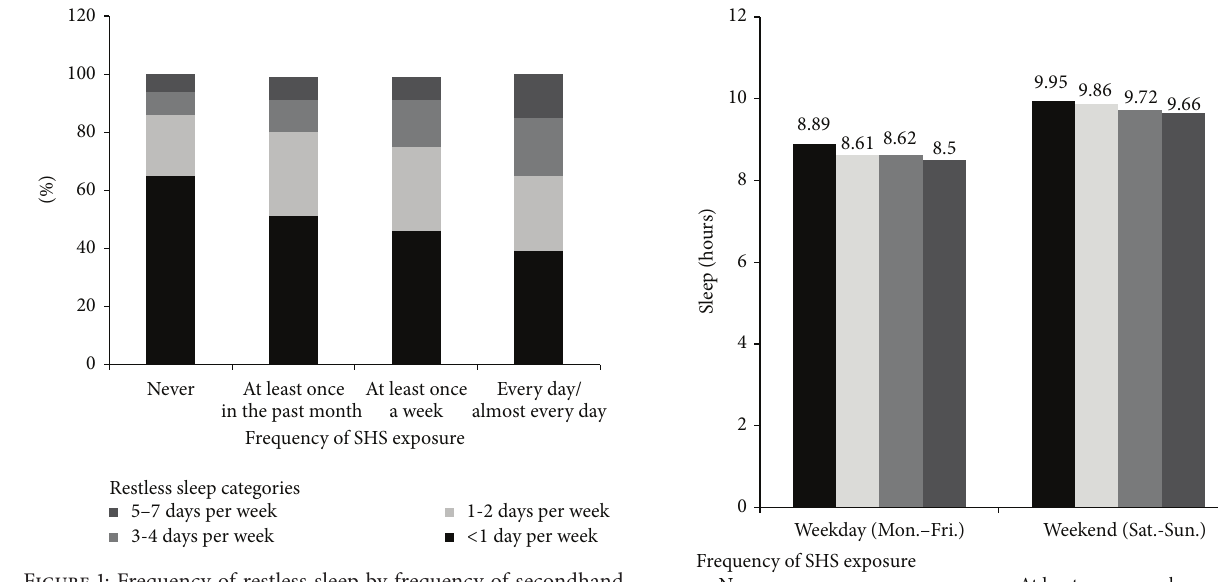
Figure 1: Frequency of restless sleep by frequency of secondhand smoke (SHS) exposure in the past month.